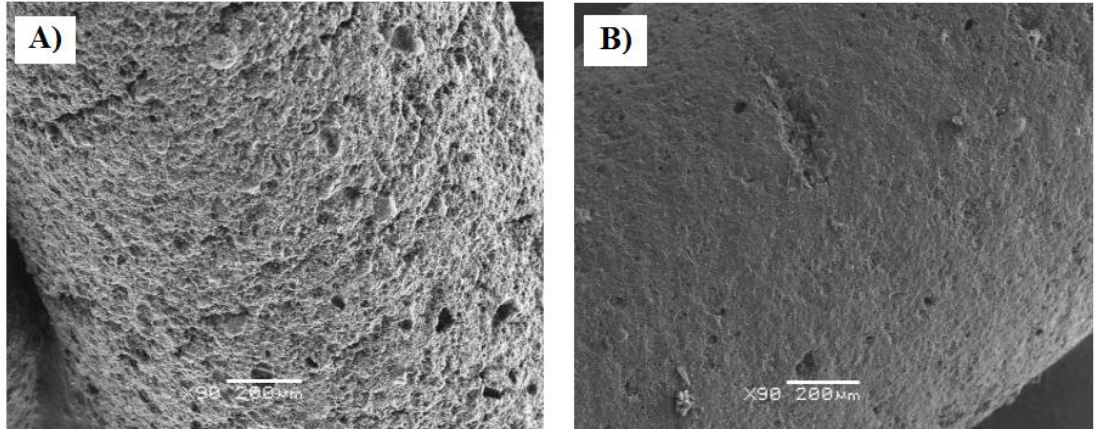
Figure 6. Biological membrane formed on granular activated carbon (( A ): before biosorption, ( B) : after biosorption))—photos from a scanning microscope.